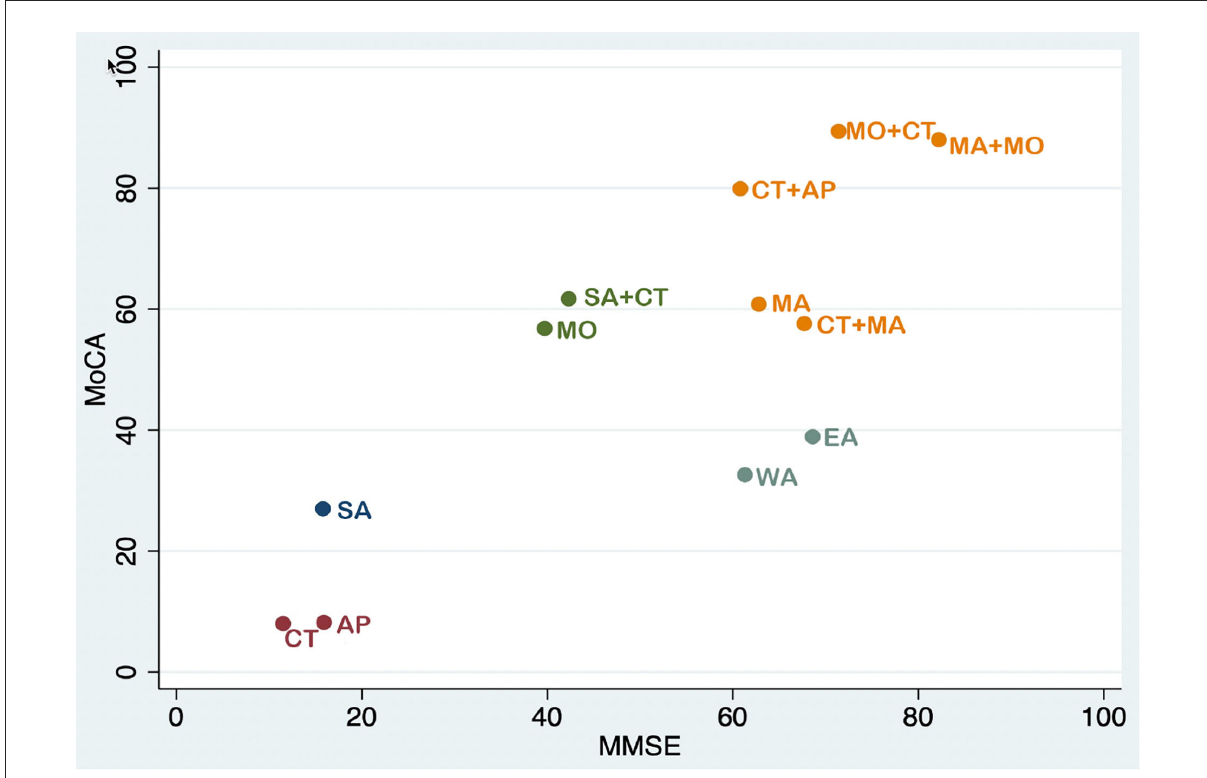
FIGURE7 Cluster ranking plot in MMSE and MoCA scores. Each color represents a group of interventions that belong to the same cluster. Interventions lying in the upper right corner were more effective than the other